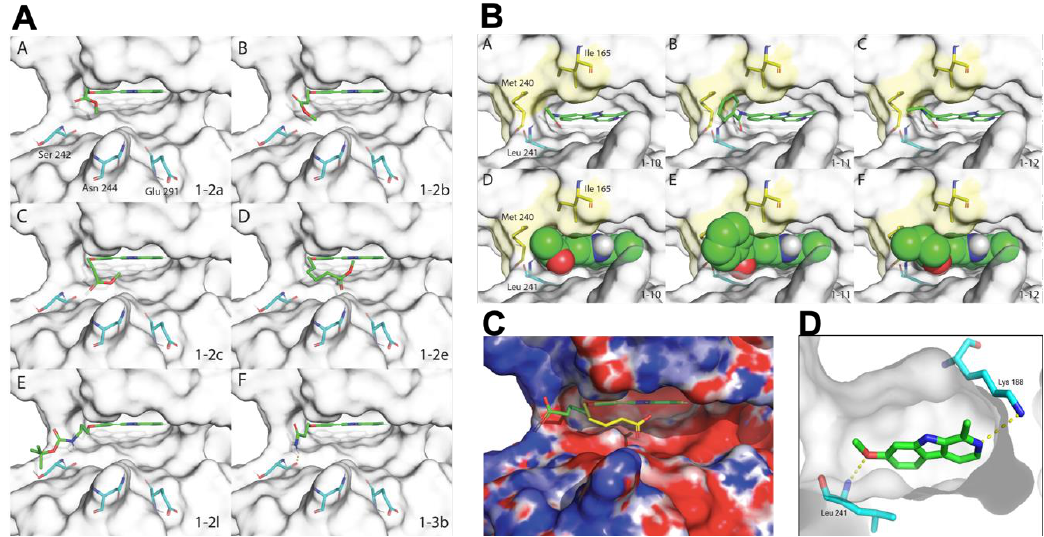
Figure 3. Docking of selected 7-substituted harmine analogs. A. Docking of 1-2a (subpanel A), 1-2b (subpanel B), 1-2c (subpanel C), 1-2e (subpanel D), 1-2l (subpanel E), 1-3b (subpanel F). Ligands are shown in green, the protein surface in gray, and selected residues in light blue. B. Docking of compounds 1-10 (subpanel A,D) , 1-11 (subpanel B,E), and 1-12 (subpanel C,F) . Subpanel A-C stick model of the ligand docked into the ATP-binding pocket of DYRK1A. Subpanel D–F, space filling models of the same structures shown in A–C. All three compounds are unable to hydrogen bond with the backbone of Leu 241 (used by harmine, panel D) due to the unfavorable orientation of their carbonyl oxygen. The hydrophobic substituents however interact with a hydrophobic cleft formed by the side chain of Ile 165 and Met 240 (shown in yellow). C. Docking of 7-substituted Harmine analogs containing carboxylic acid groups. Compound 1-4c is shown in green and compounds 1-4e in yellow. D. Harmine bound to DYRK1A (PDB 3ANR). The surface of the protein is colored according to the electrostatic potential (red for negative and blue for positive).